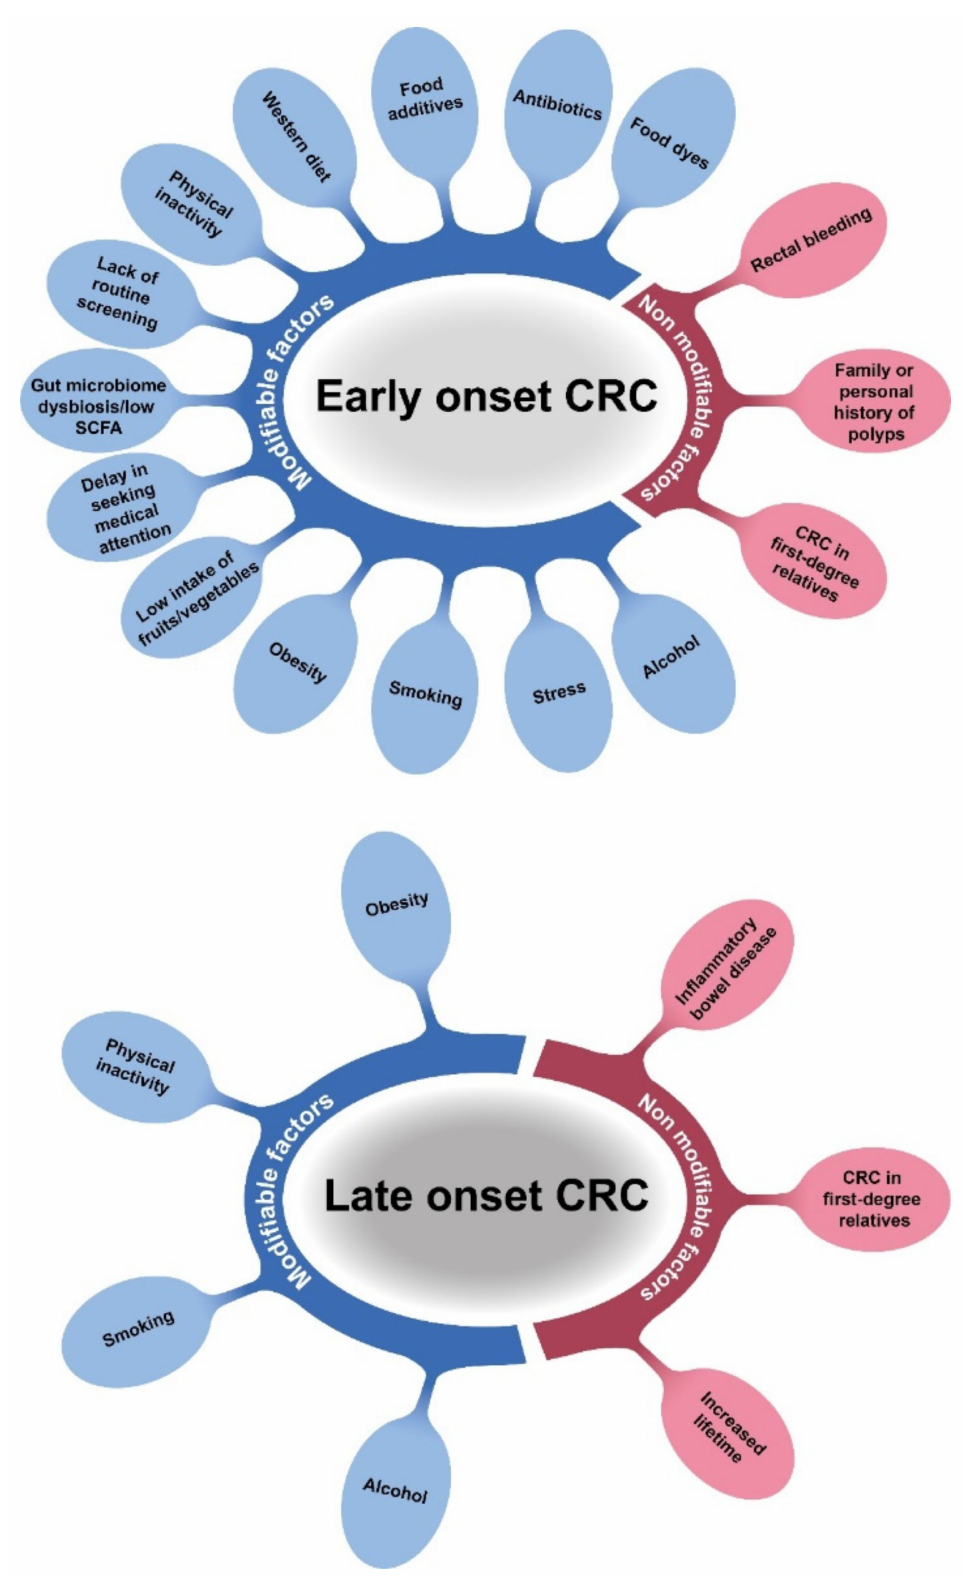
Figure 4. Modifiable and non-modifiable risk factors associated with early- or late-onset